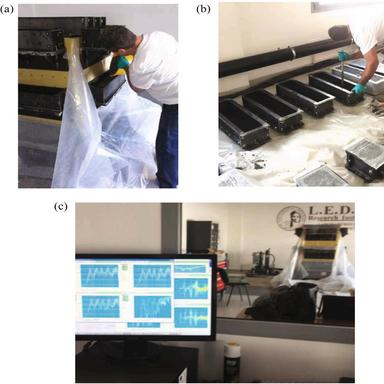
(a) Casting of the mortar in the moulds placed on the Team CUBE™ shaker. (b) Casting of the mortar in the moulds placed on the ground. (c) Execution of the vibration test.